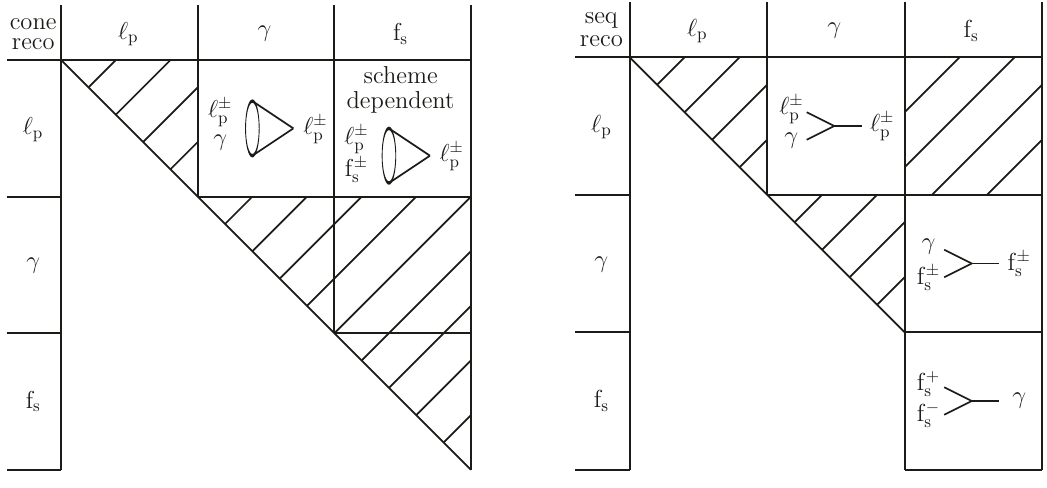
Figure 5 . Recombination matrices of lepton dressing strategies beyond photon radiation. While γ labels the photon, ‘ p and f s denote the primary leptons and secondary flavours,